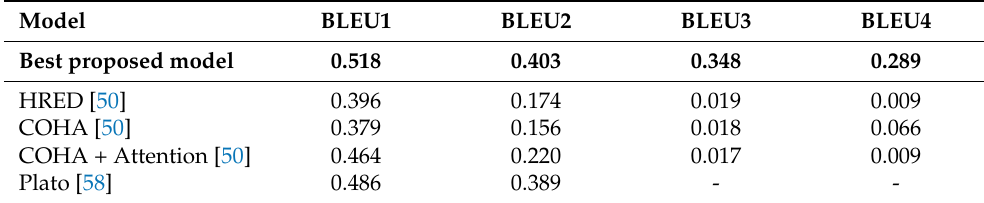
Figure 7. Average of the BLEU scores and ROUGE score with different lengths of simulated conversation. Table 4. Comparison of proposed model with recent studies.